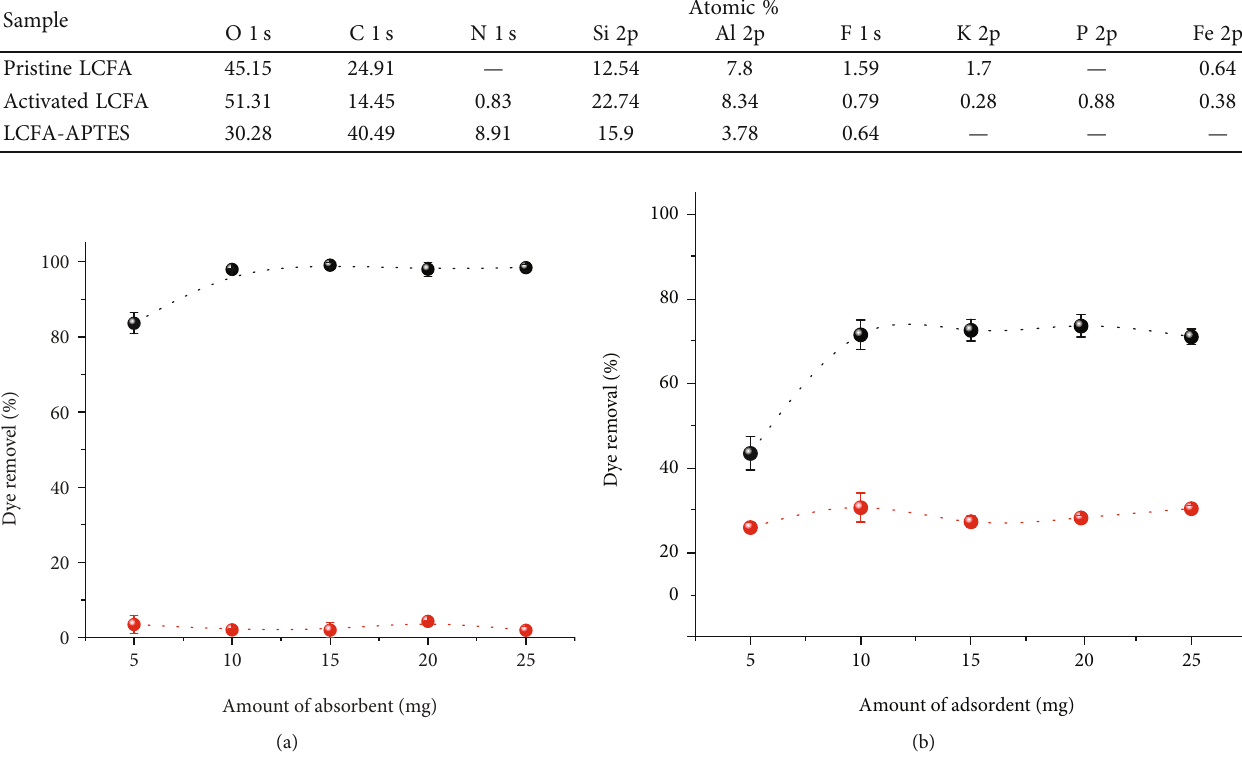
Figure 3: E ff ect of amount of adsorbent on dye removal percentage: (a) MO ( pH = 4 , t = 5 min , T = 25 ° C ), (b) XO ( pH = 4 , t = 5 min , T = 25 ° C ), removal by LCFA (red symbol), and LCFA-APTES (black symbol). The error bars represent the standard deviation of at least three repeated measurements.